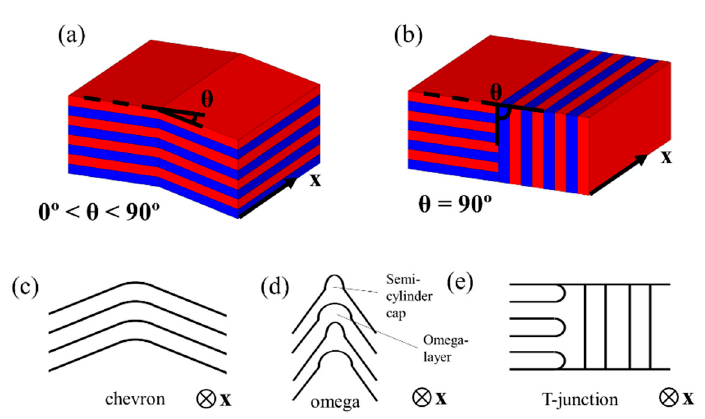
Figure A2. Overview of tilt grain boundary morphologies. ( a ) Two grains of lamellar block copolymer tilted under an angle well below 90°, ( b ):two grains of lamellar block copolymer tilted under an angle of 90°, ( c ) 2D-scheme of the IMDS of a low-tilt-angle chevron grain boundary, ( d ) 2D-scheme of the IMDS of an omega grain boundary, ( e ) 2D-scheme of the IMDS of a pure T-junction as observed in 90° tilt grain boundaries.